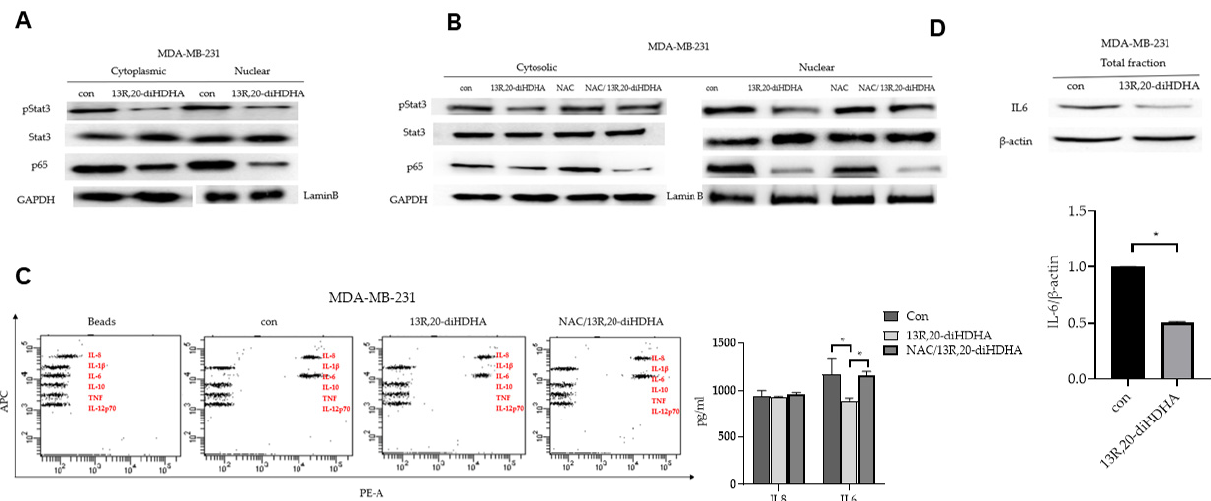
Figure 5. Effects of 13 R ,20-diHDHA on Stat3 pathway activation in mammospheres and CSC loads in breast cancer. ( A ) The activation of Stat3 and NF- κ B was determined in mammospheres using antibodies against pStat3, Stat3, p65, and GAPDH, Lamin B. 13 R ,20-diHDHA decreased the nuclear levels of pStat3 and p65 in the mammospheres. ( B ) The effects of 13R,20-diHDHA and NAC on pStat3 phosphorylation. The 13 R ,20-diHDHA-induced dephosphorylation of pStat3 was ameliorated by NAC. ( C ) Cytokine profile assay of the conditioned media of control and 13 R ,20-diHDHA-treated cells, as performed using specific antibodies and cytokine beads. The quantification of cytokines already been done using by BD CBA cytokine assay kit and FCAP Array program. ( D ) Mammospheres culture cells were immunoblotted with antibodies against IL-6 and β -actin (internal reference protein). The data from triplicate experiments are presented as the mean ± SD. * p < 0.05 versus the DMSO-treated control